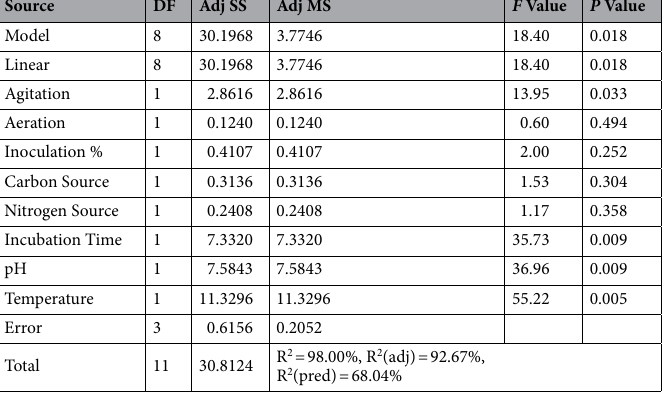
Table 3. ANOVA for